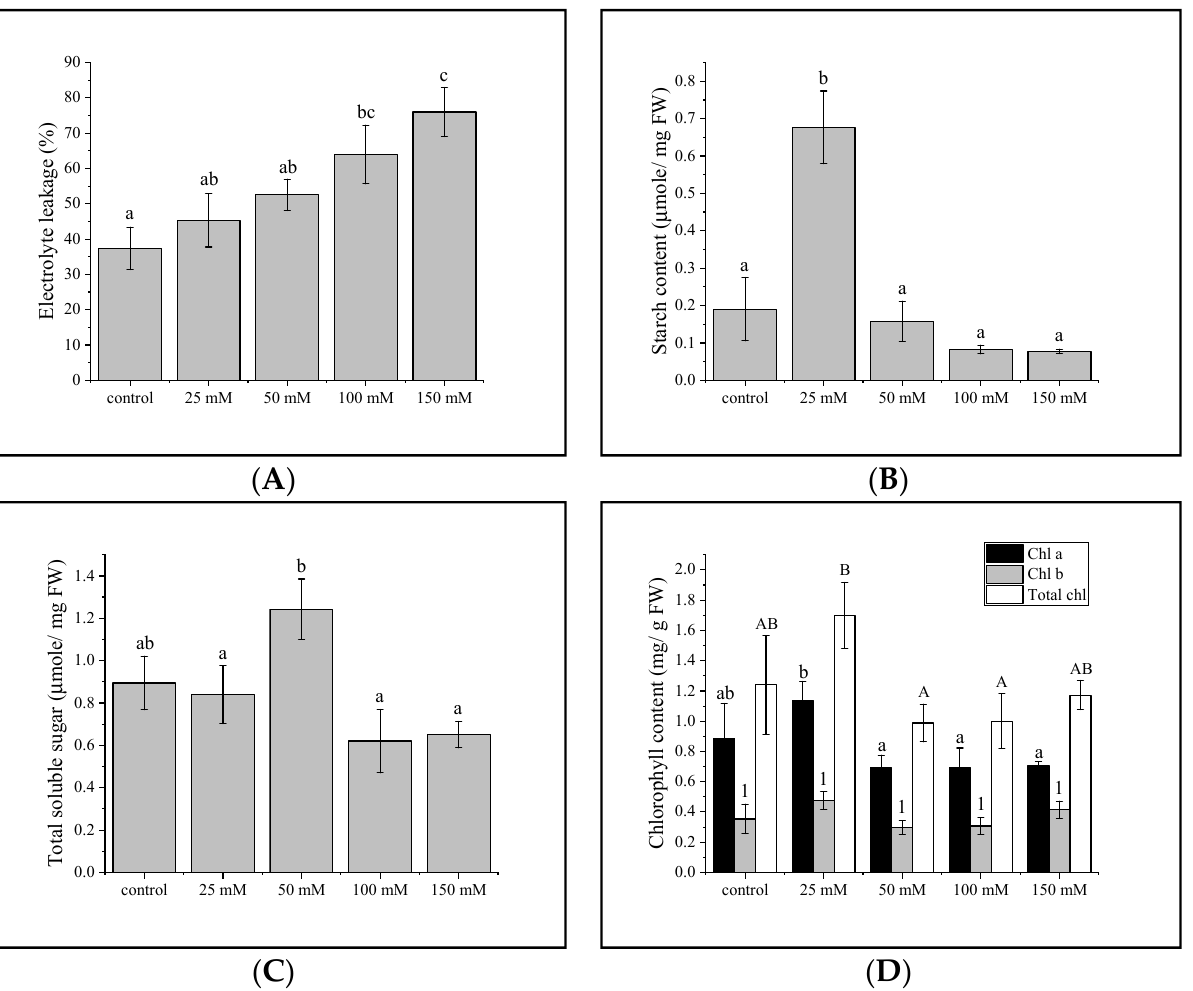
Figure 1 . Gac seedlings leaf response to increasing soil salinity. ( A ) Rate of electrolyte leakage, ( B ) starch content, ( C ) total soluble sugar. Different lowercase letters indicate significant differences between treatments (p < 0.05). ( D ) Chlorophyll a, b and total chlorophyll in gac leaf at the seedling stage. Values are means ± SE ( n = 6). Lower case letters, numbers, and capital letters denote significant differences in chlorophyll a, chlorophyll b, and total chlorophyll content, respectively, between treatments ( p < 0.05).